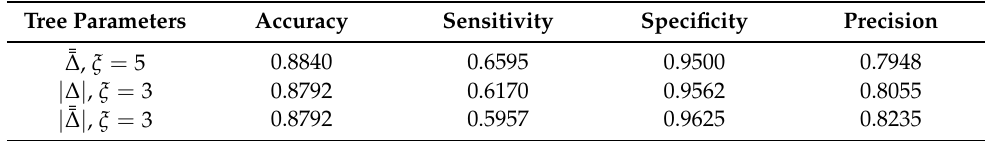
Figure 5. Decision trees and confusion matrices of the best results of Table 5. ( a ) Decision tree ( left ) and confusion matrix ( right ) for the metric ¯¯ ∆ , using w h = 1, w g = 1 and maximum number of splits ξ = 5. ( b ) Decision tree ( left ) and confusion matrix ( right ) for the metric | ∆ | , using w h = 1, w g = 1 and maximum number of splits ξ = 3. ( c ) Decision tree ( left ) and confusion matrix ( right ) for the metric | ¯¯ ∆ | , using w h = 1, w g = 1 and maximum number of splits ξ = 3. Table 6. Performances of the best classification trees ( w h = 1, w g = 1). Tree Parameters Accuracy